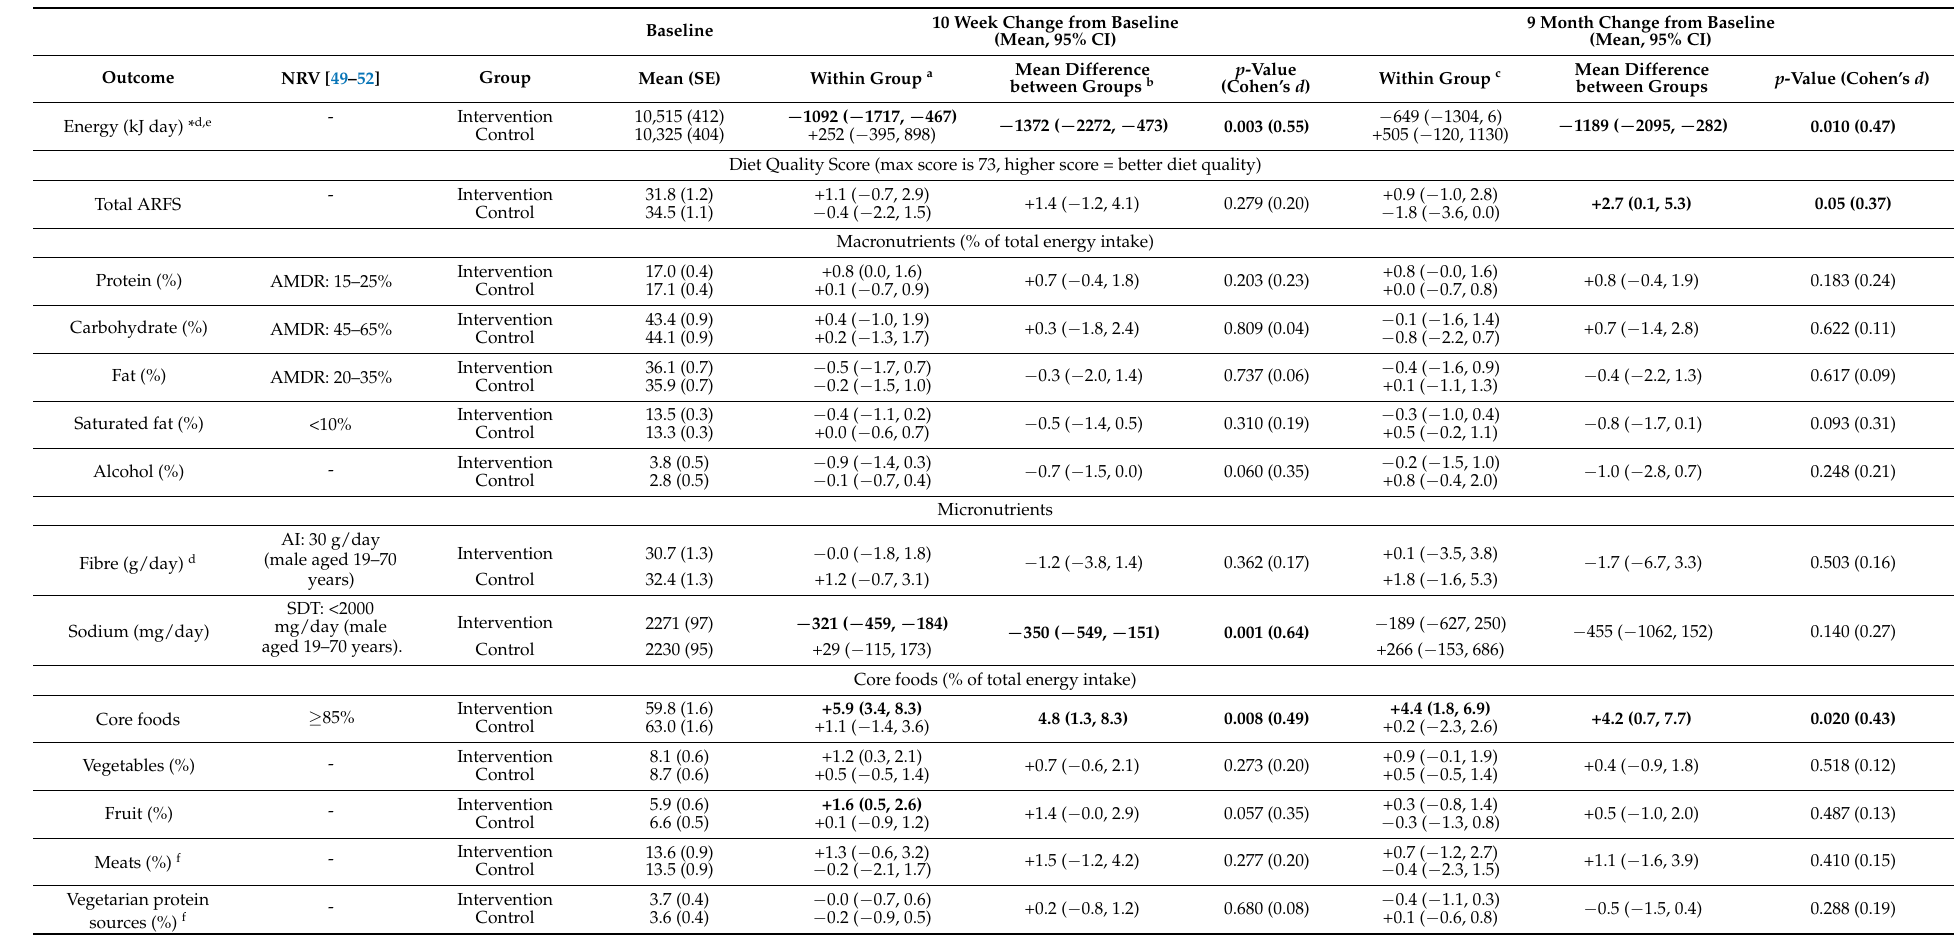
Table 3. Change in dietary intake of fathers enrolled in the Healthy Youngsters, Healthy Dads (HYHD) RCT (intention to treat). Baseline 10 Week Change from Baseline (Mean, 95%